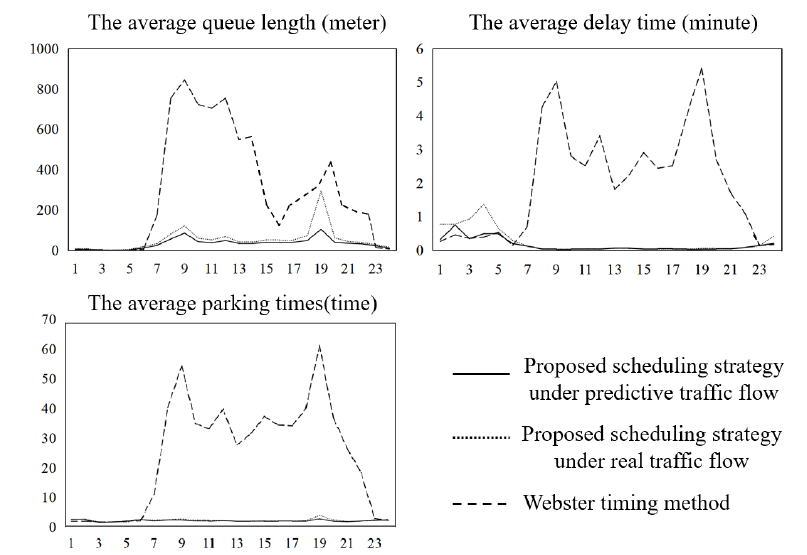
Figure 10. Comparison average values of the queue length, delay time, and parking